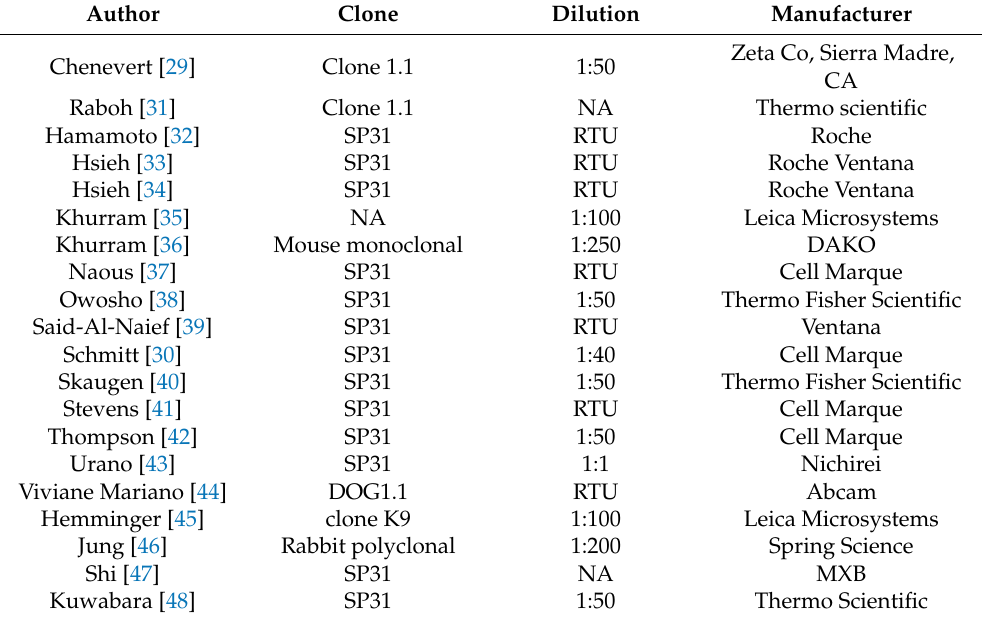
Table 3. DOG1 primary antibody clones, dilutions and manufacturers’ specifications regarding immunohistochemical analyses performed in the included studies.